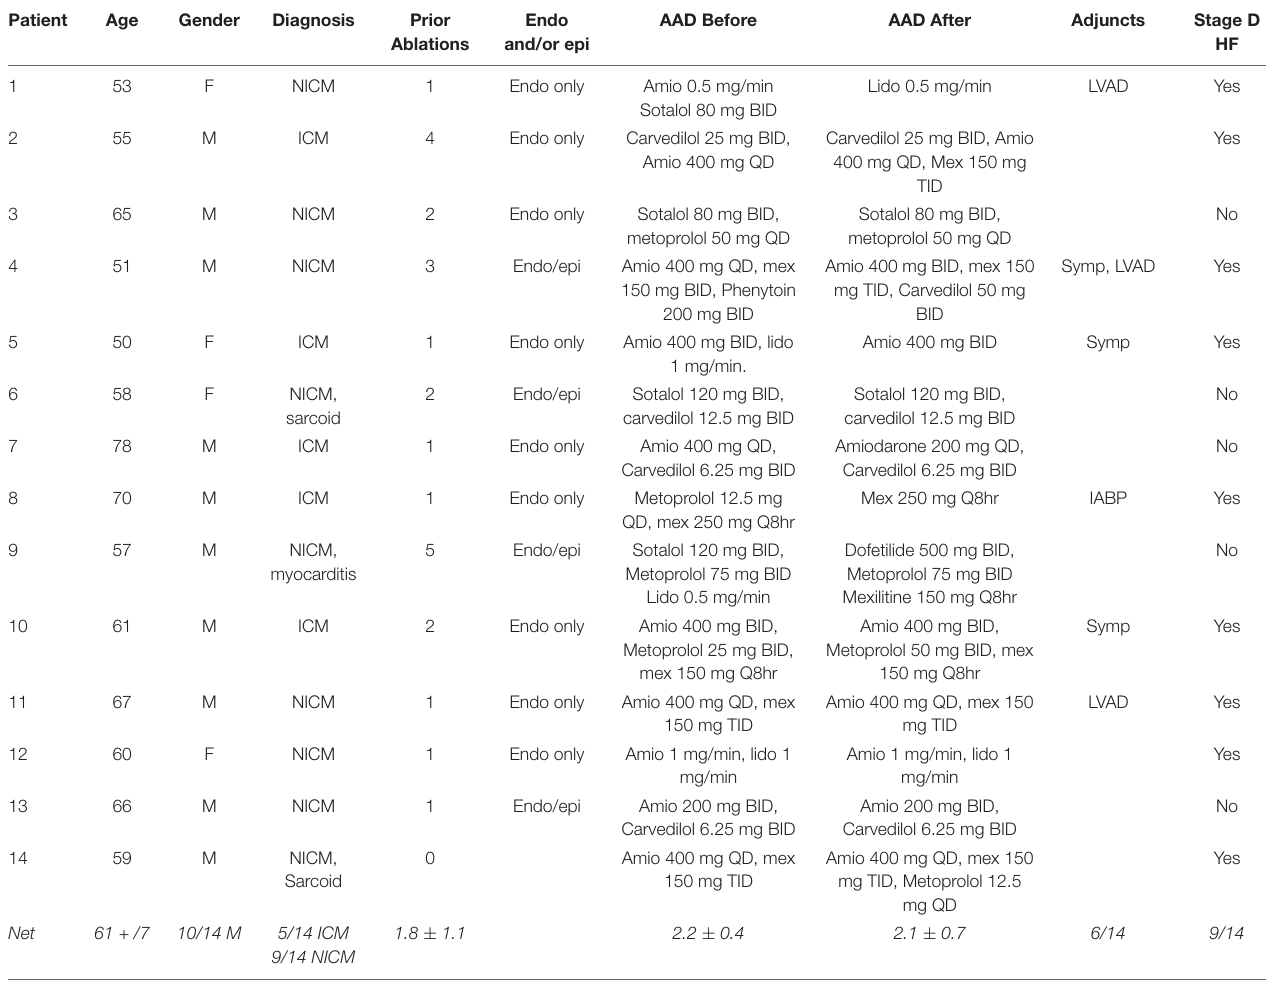
TABLE 1 | Characteristics of 14 patients undergoing SBRT.